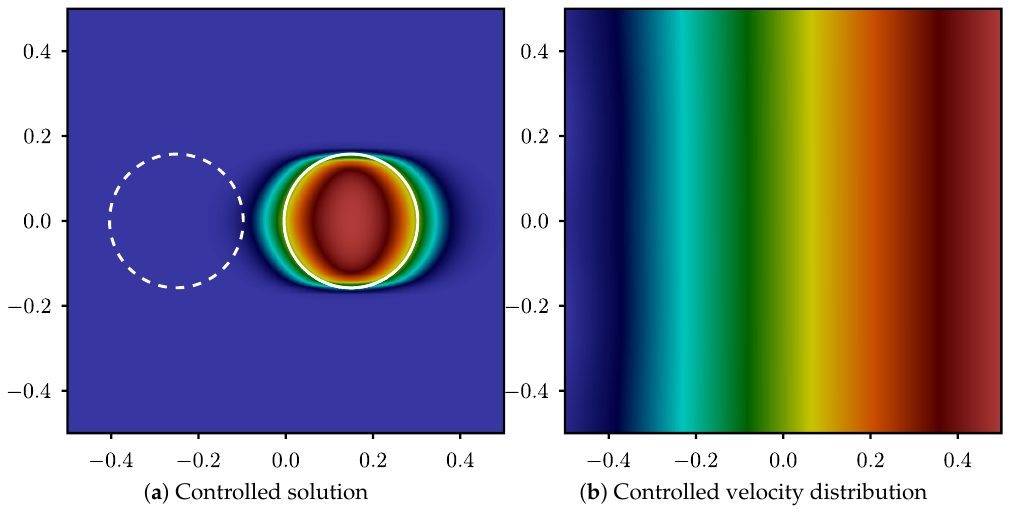
Figure 6. Volume fraction and velocity potential of the controlled solution: The dashed circle represents the initial location of the interface and the solid circle represents the desired interface location at T =